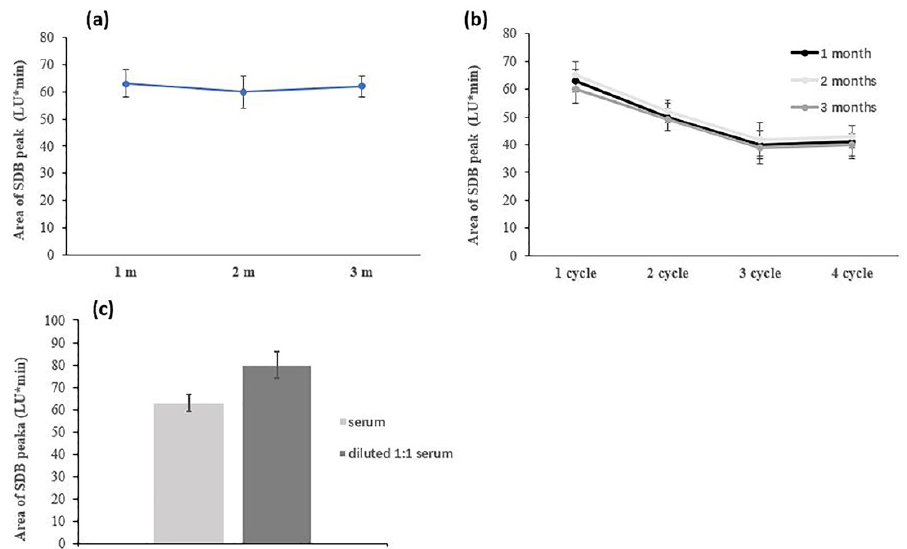
Figure 3. Area of SDB peak for a serum sample ( a ) stored at − 20 °C for 1, 2 or 3 months; and ( b ) after repeated freeze–thawing cycles at 1, 2, or 3 months. ( c ) Effect on SDB peak area of 1:1 dilution in physiological solution of serum samples.